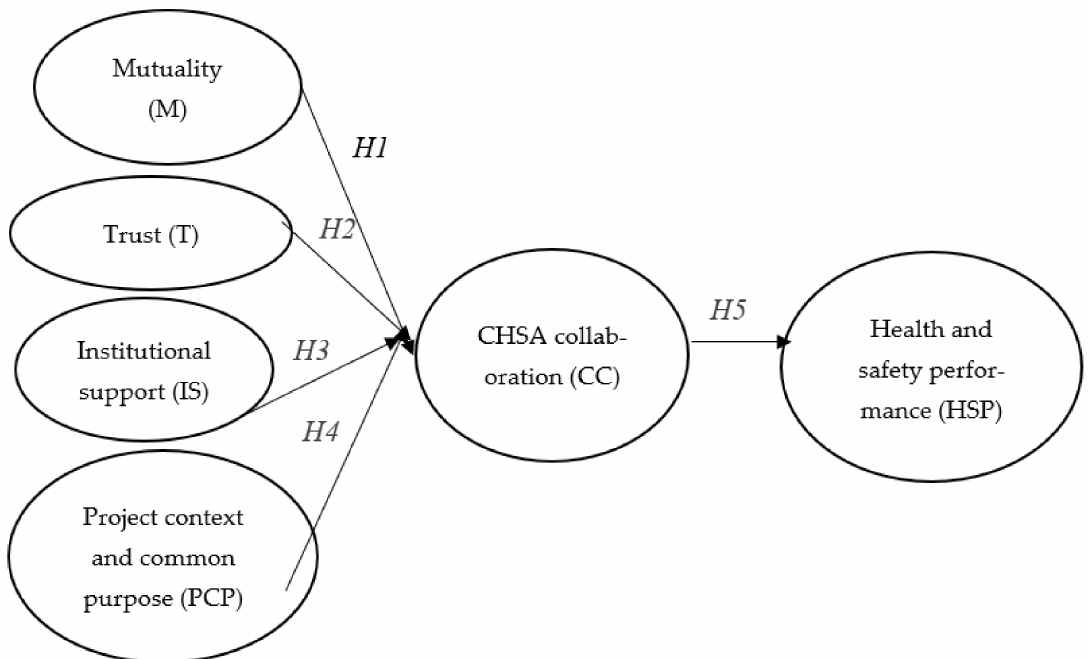
Figure 4. A model for improving construction health and safety agent collaboration and influence on health and safety